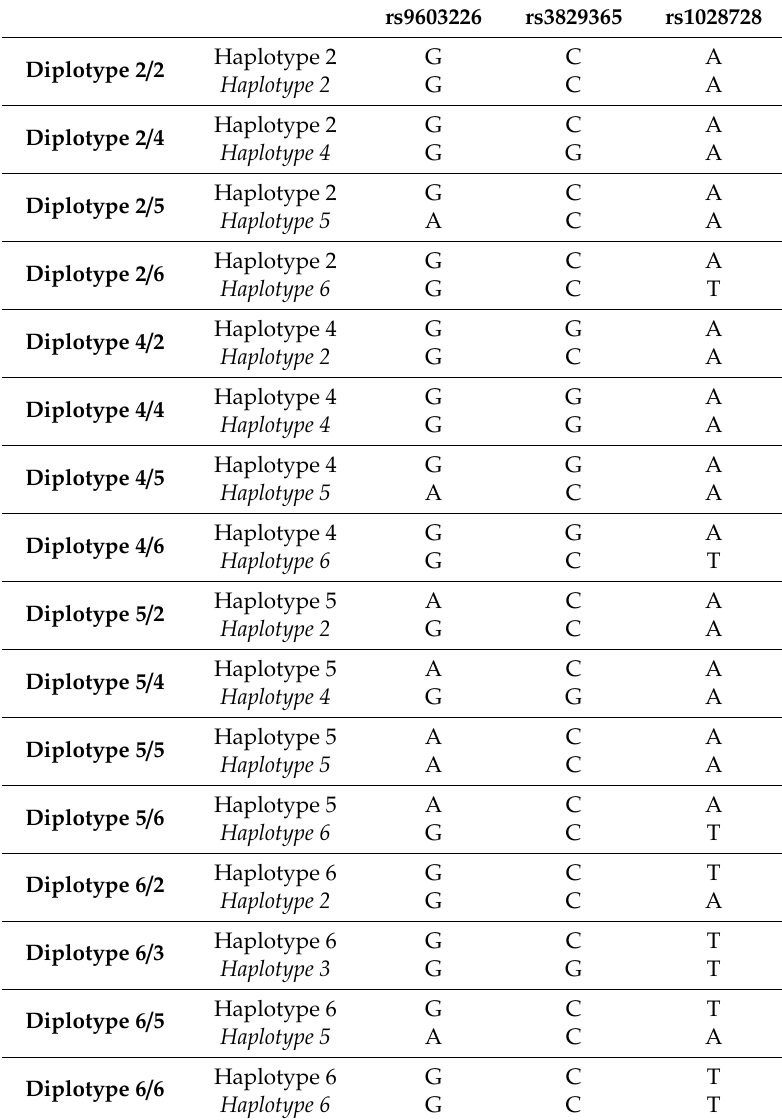
Table A1. POSTN gene diplotypes based on the 6 haplotype combinations found in the studied population. One out of the two haplotypes present on the chromosome pair is written in